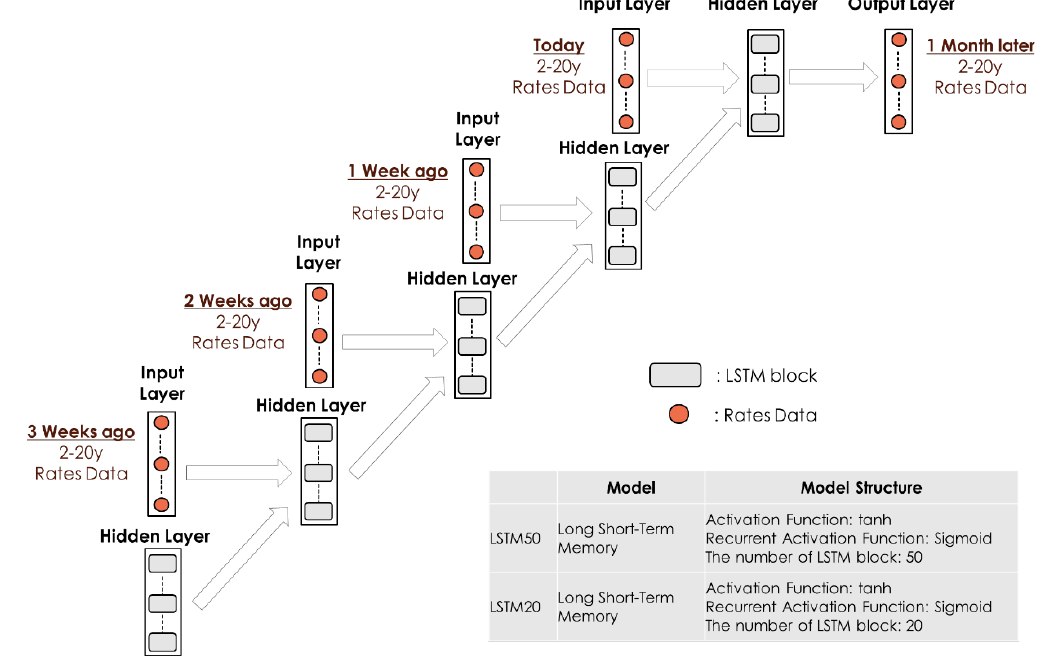
Figure 17. Structure of the Long Short-Term Memory (LSTM) model.